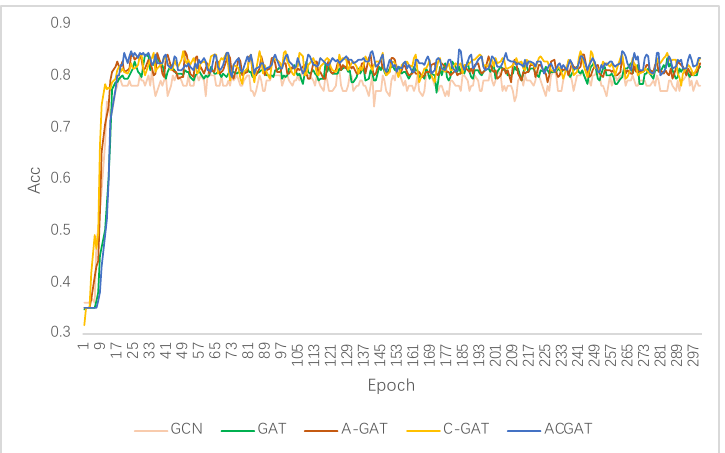
Figure 13. Comparison results of neural network models on the Cora citation